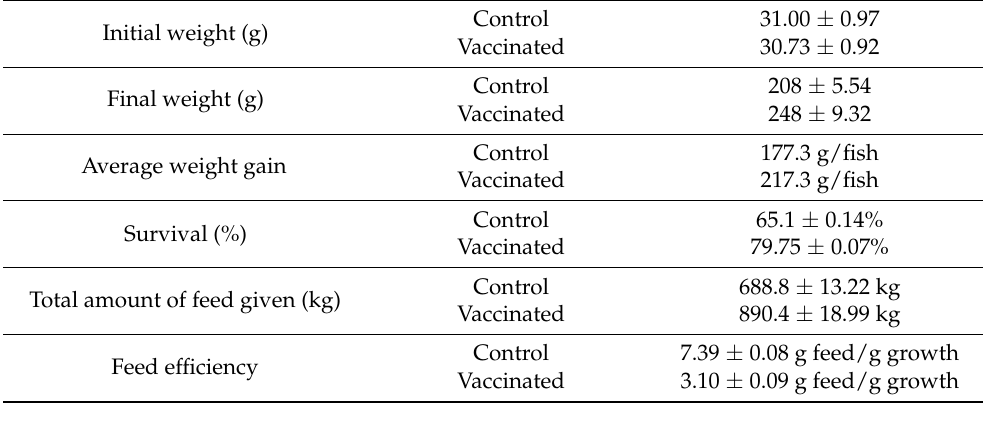
Table 5. Hybrid grouper fed with Vibrio harveyi strain VH1 (1 × 10 7 CFU/g feed) at 4% body weight according to the vaccination regime. Fifteen fish were randomly selected from each group every two weeks. Vibrio harveyi strain VH1 feeding group showed increased feed efficiencies.